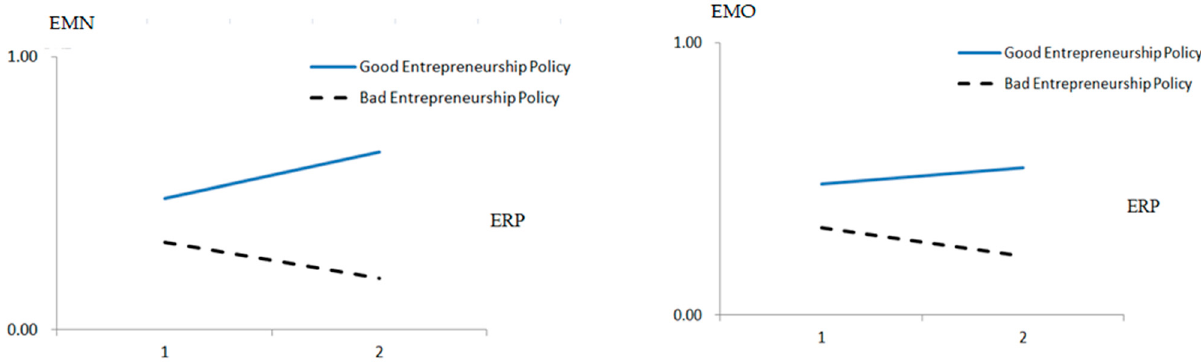
Figure 2. The moderating effect of the entrepreneurship policy. ERP is entrepreneurial risk per- ception, EMN is entrepreneurs motivation driven by necessity, EMO is entrepreneurs motivation driven by